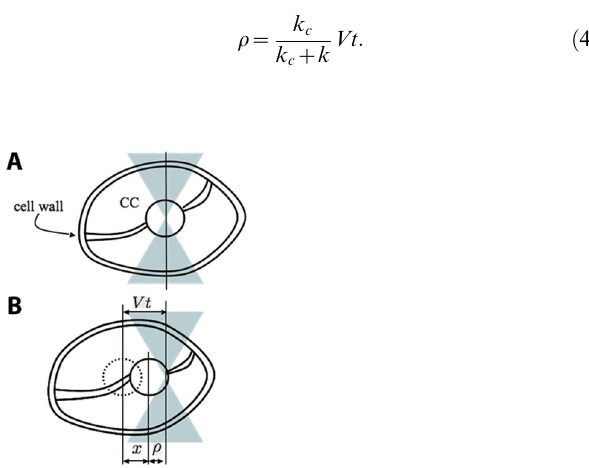
Figure 1. Schematic representation of the experiment with optical tweezers. a) CC in the equilibrium position of the OT. b) When the sample moves with velocity V , the alga cell moves accordingly with the same velocity. There appears to be a tug of war between the cell and the OT, as the CC changes its equilibrium position in the trap by an amount characterised by r , and the structures that attach the CC to the cell wall exhibit a deformation given by x ; t is the time interval in relation to the beginning of the